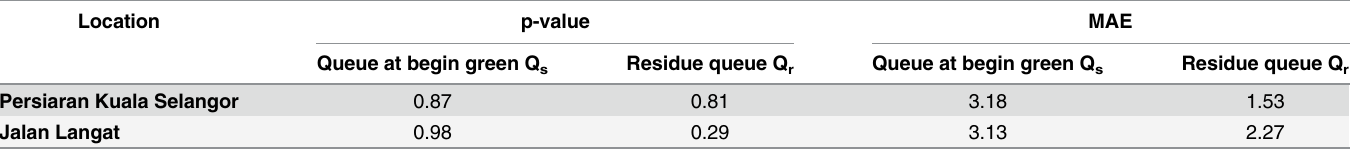
In this work, the authors proposed platoon interaction algorithms to the LWR-IM model to describe platoon interactions in urban arterials. Consequently, the work also aims to quantita- tively validate the LWR-IM and its underlying algorithm with real-world data. The LWR-IM and the proposed algorithm has been applied and implemented in a real-world class I and class II arterials. Validation of the model is conducted with real queue data to ascertain: (i) its ability to simulate queues that closely resemble actual queues and (ii) the viability of the platoon inter- action algorithms of producing accurate and utilizable platoon arrival profile. The results from the t-test with p-values range from 0.29 and 0.98 for four sets of comparisons between real and simulated queues at both class I and class II arterials evidently prove that both criteria have been appropriately validated as real and simulated queues did not differ significantly from each other. In addition, the statistical evaluations via the mean absolute error reveal low absolute Table 9. p-value and mean absolute error (MAE).